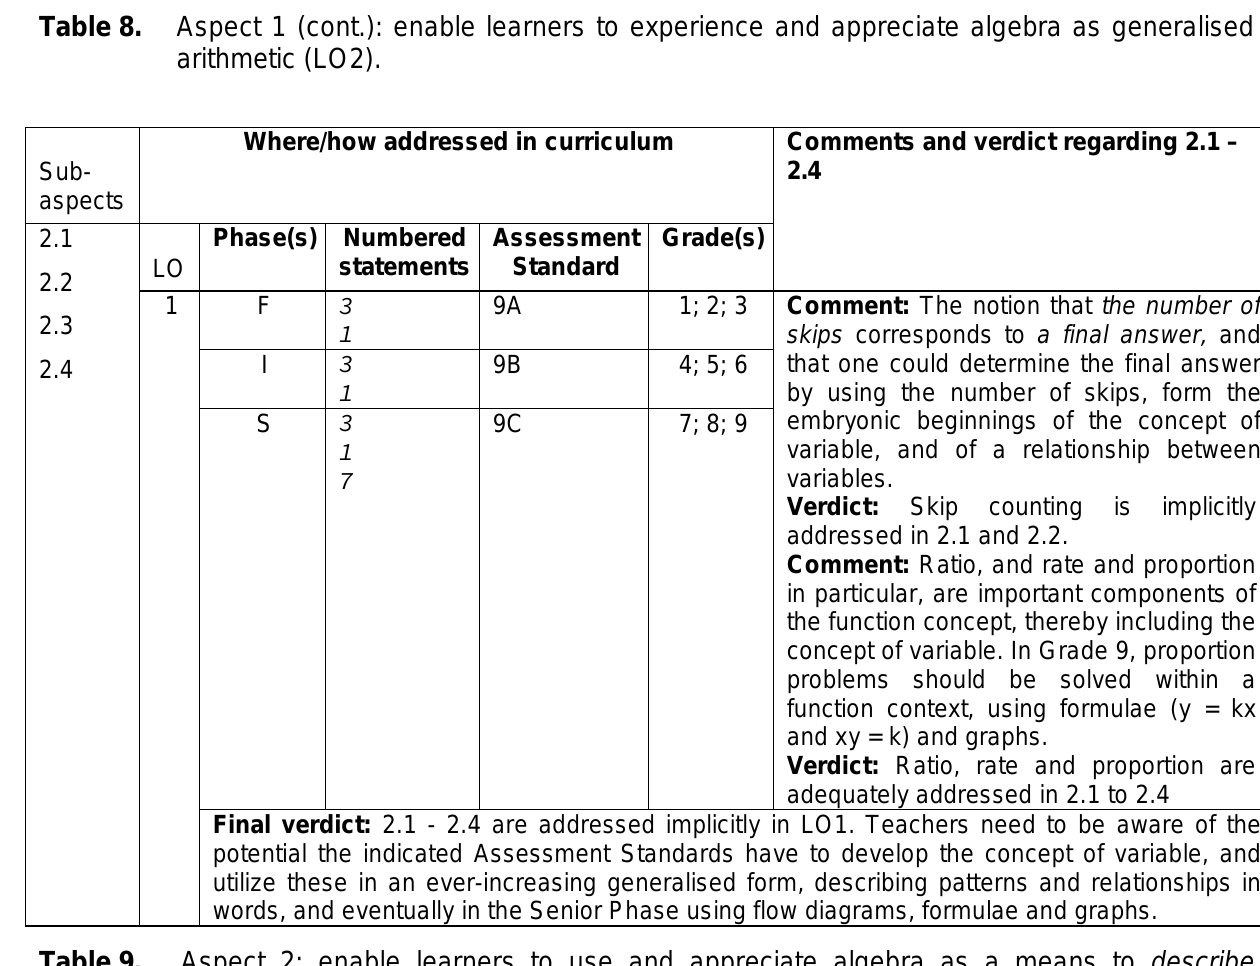
Aspect 2: enable learners to use and appreciate algebra as a means to describe relationships between quantities that vary (namely, variables ) inside and outside mathematics